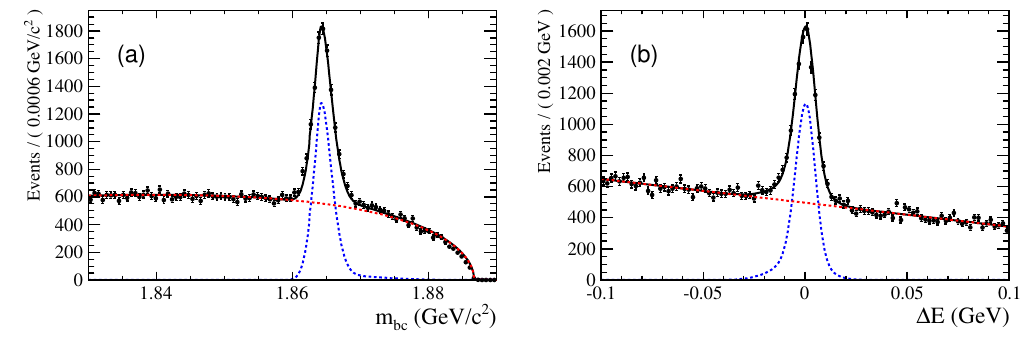
Figure 3 . Beam constrained mass (a) and missing energy (b) distribution of D 0 ! (cid:25) + (cid:25) (cid:0) (cid:25) + (cid:25) (cid:0) candidates, overlaid with the projections of the (cid:12)tted PDF (solid black line). The signal component is shown in blue (dashed) and the background component in red